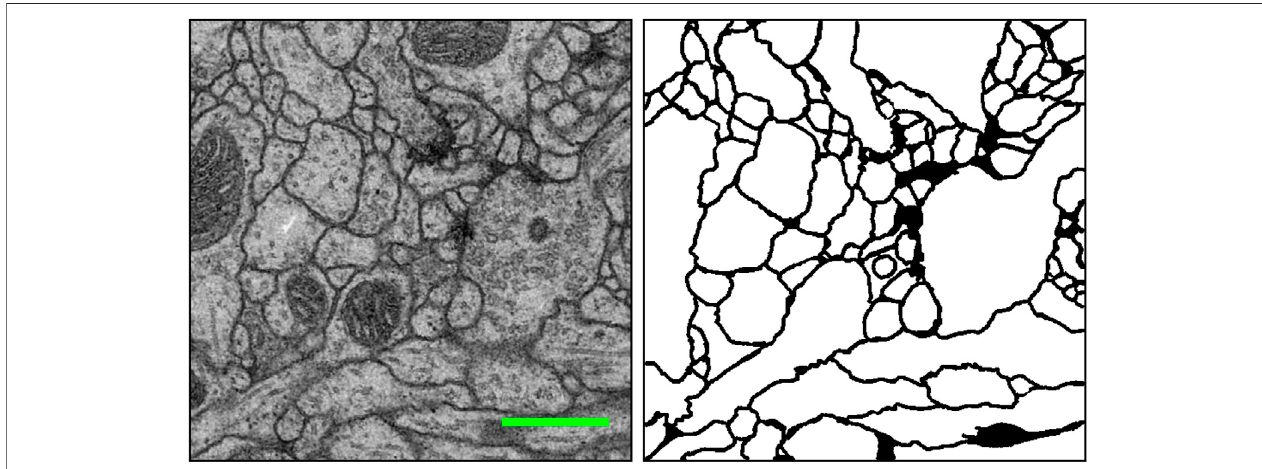
FIGURE 1 | An example EM image (left) and its manually extracted cellular membrane segmentation result (right) from the ISBI 2012 EM segmentation challenge (Arganda-Carreras et al., 2015). Scale bar (green): 500